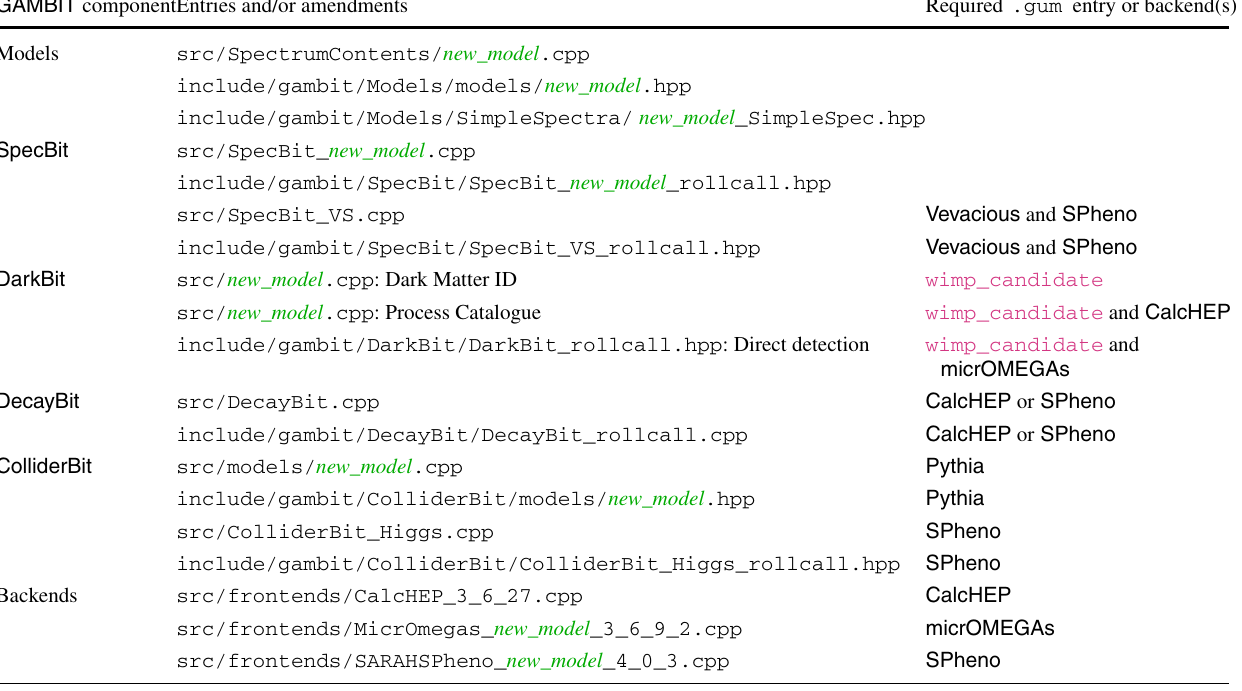
Table 2 Details of the new files that GUM writes or modifies in each part of GAMBIT , for the .gum file entry model: new_model . Some filesareonlywrittenoreditedwhenamodel-specificversionofapartic- ularbackendisrequestedinthe .gum